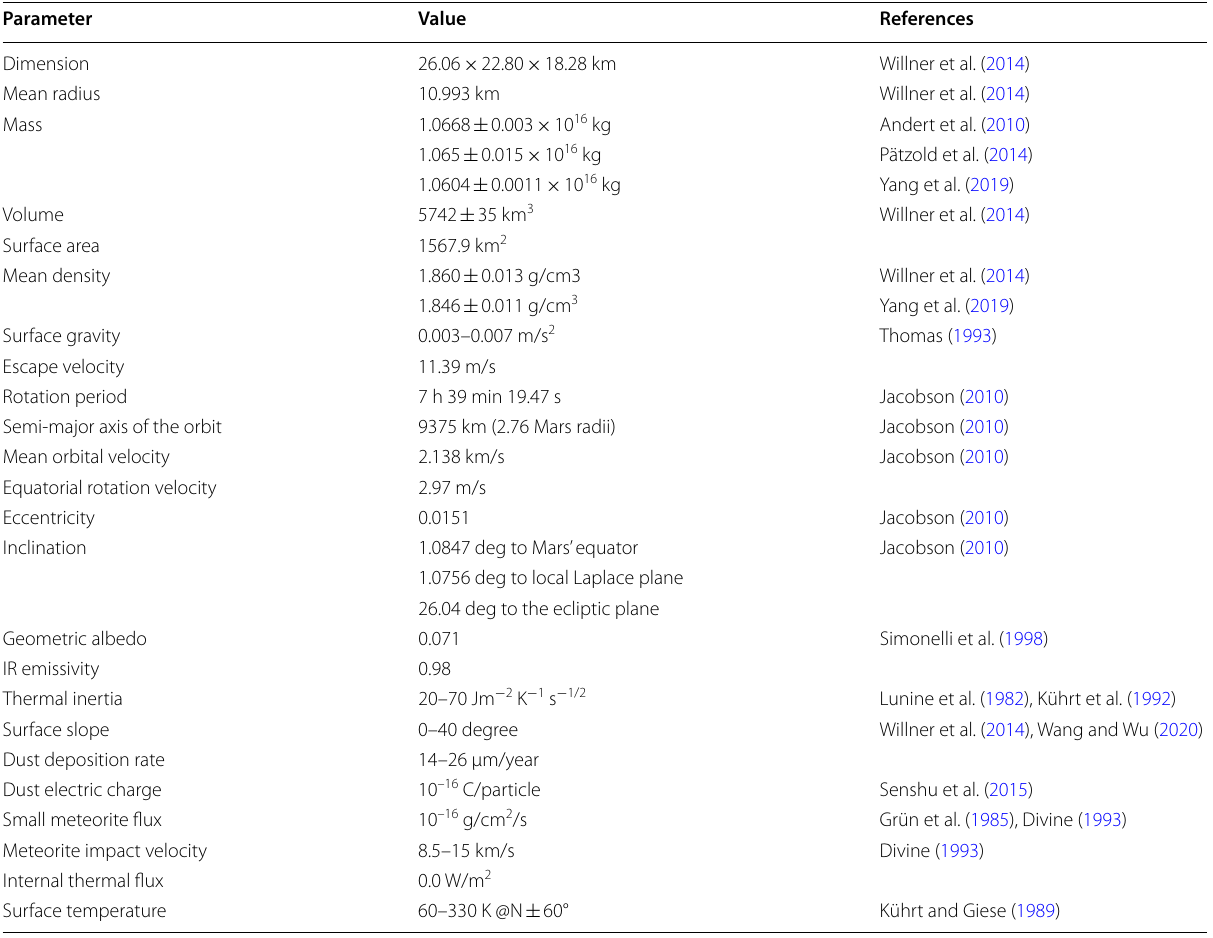
Table 1 General characteristics of